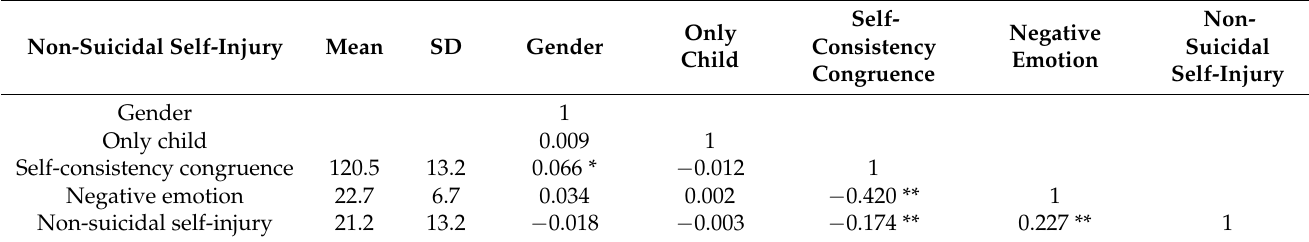
Table 1. Correlation analysis of